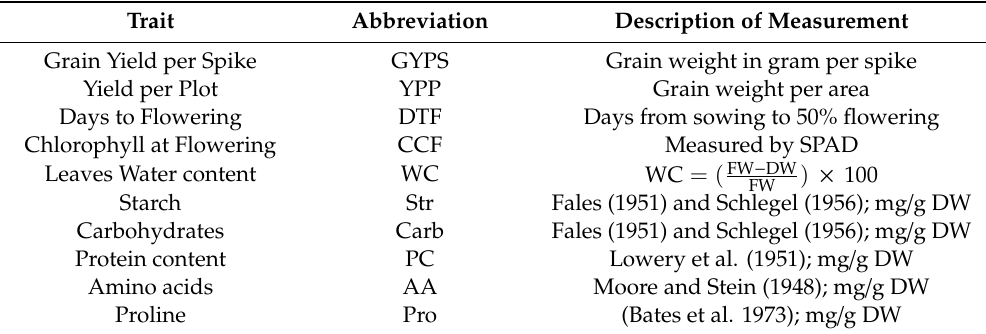
Table 1. The names, abbreviations, and descriptions of measurements of all traits. Trait Abbreviation Description of Measurement Grain Yield per Spike GYPS Grain weight in gram per